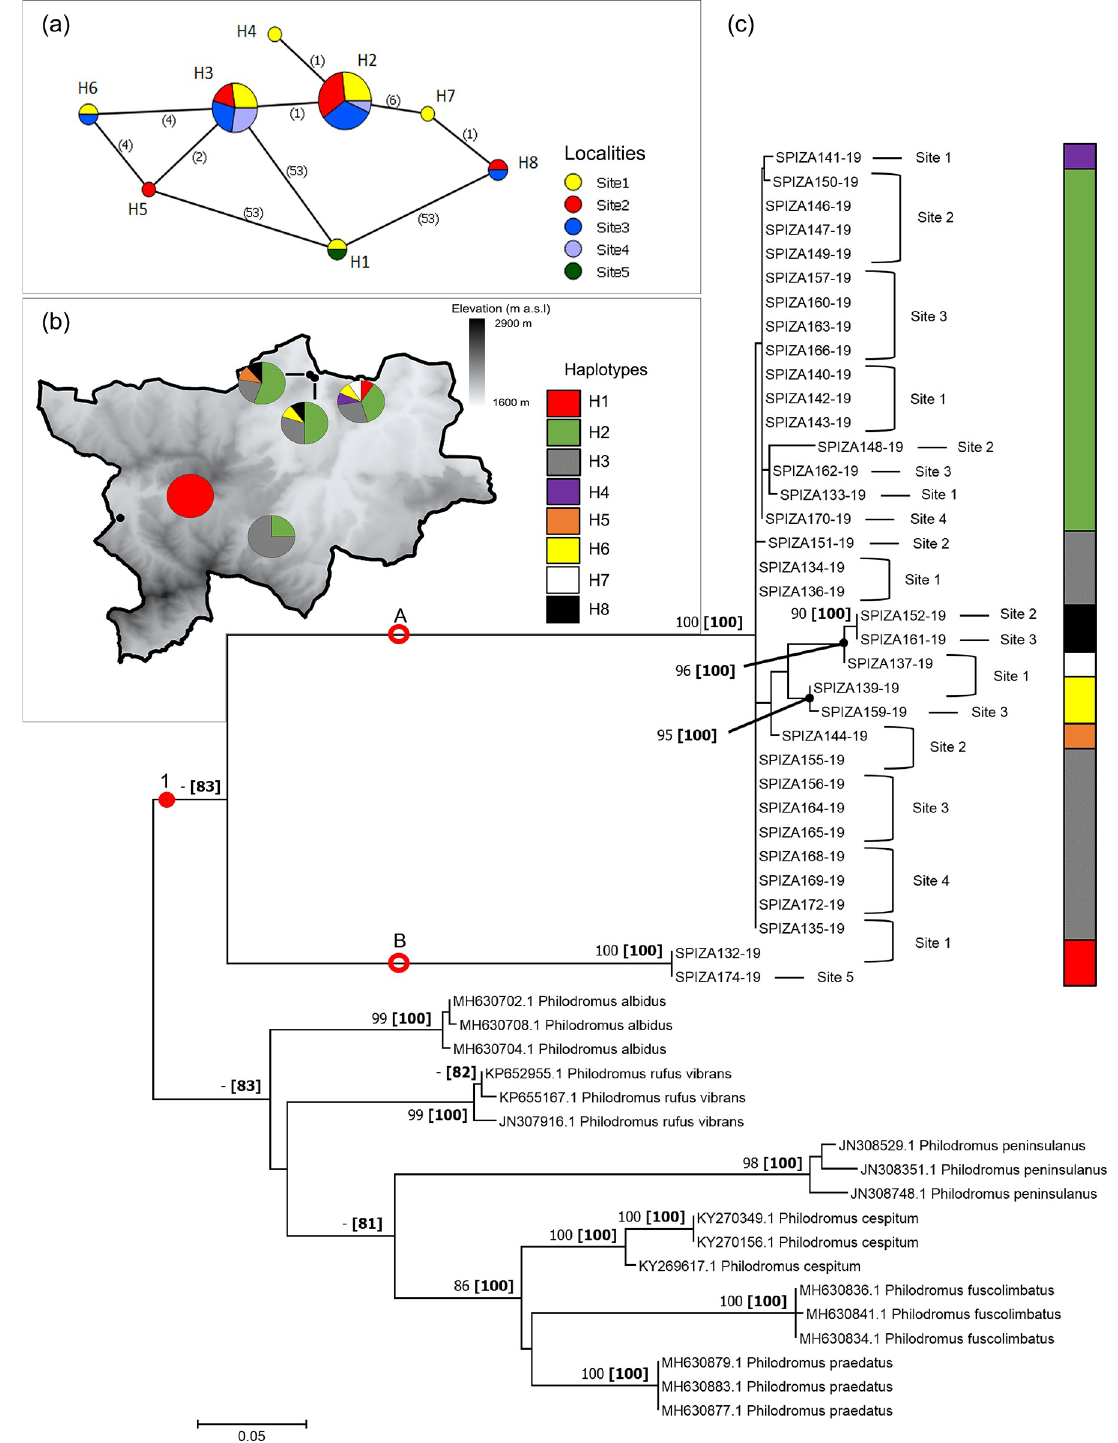
Fig 5. Haplotype networks and phylogram of Philodromus browningi populations of the Golden Gate Highlands National Park, based on a portion of mt DNA COI gene. (a) Minimum Spanning Network (MSN) connecting sampled sequences through putative mutational steps according to geographical locality of populations. Circles represent defined haplotypes, while circle diameters are proportional to frequency. Numbers in parentheses correspond to mutational steps. (b) Distribution of defined haplotypes within sampled localities. (c) Phylogenetic tree based on Maximum Likelihood (ML) showing relationship of P . browningi with six sister species.